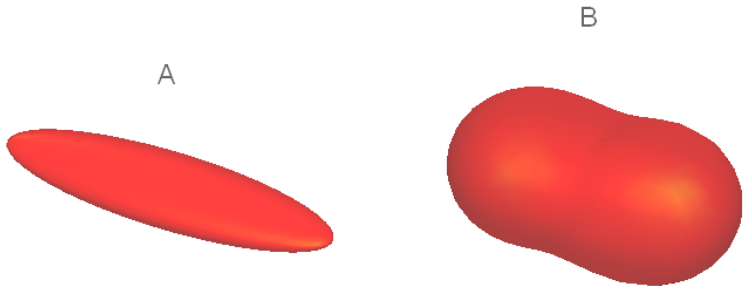
Figure 1. ( A ) The ellipsoid, i.e. , the unit level set of the inverse of a diffusion tensor; and ( B ) the glyph determined by the same diffusion